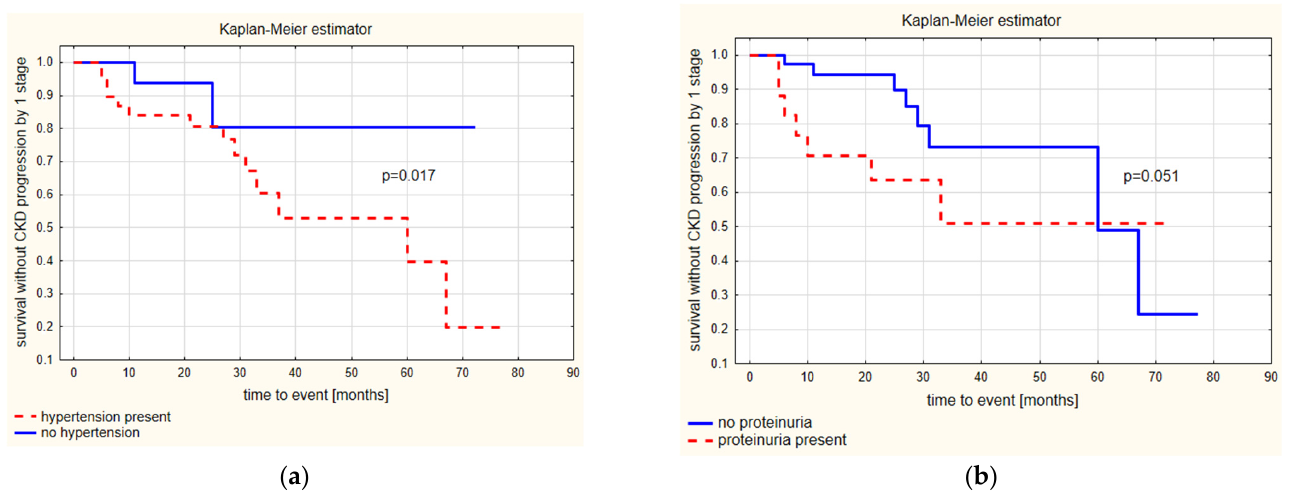
Figure 2. Kaplan–Meier estimator (F Cox test) for survival without CKD progression by ≥ 1 stage for children ( a ) with and without initially diagnosed arterial hypertension and ( b ) with and without initially present proteinuria.